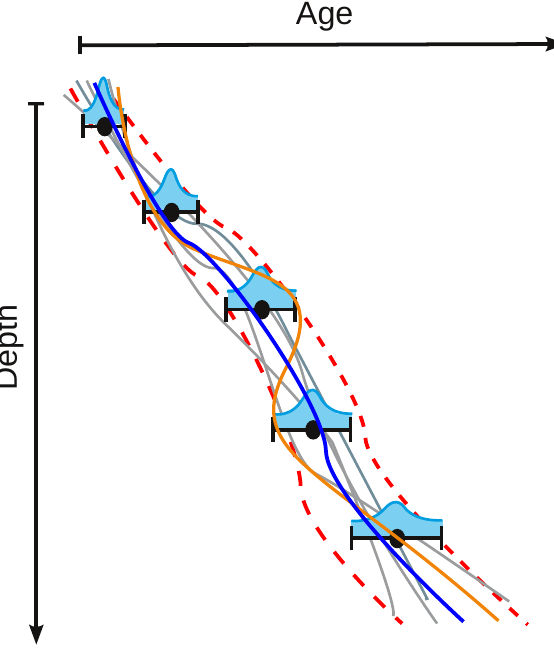
Fig. 1. Schematic of the Monte Carlo model: the point estimates are identified with normal distributions whose standard deviation equals the measurement error (represented here as cyan shaded ar- eas over the error bars of each point estimate). Several realizations of the Monte Carlo simulation are shown as gray and brownish curves. The brownish curve includes an age reversal and is subse- quently rejected. The median (blue) and the confidence limits (red dashed) represent the final age model resulting from a series of dif- ferent Monte Carlo